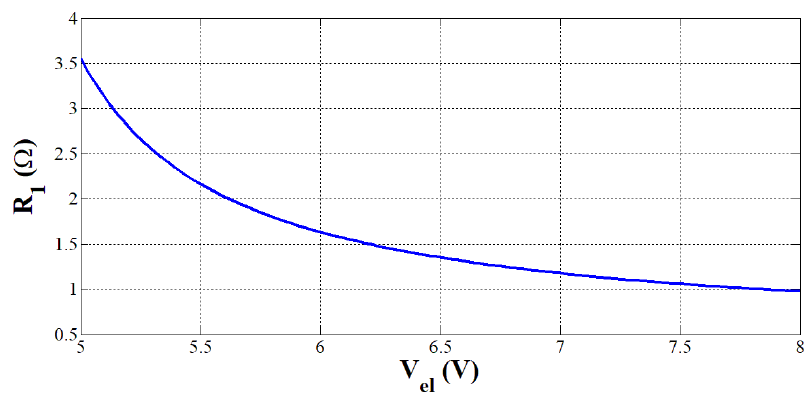
Figure 14. Resistance value variation according to PEMEL voltage.